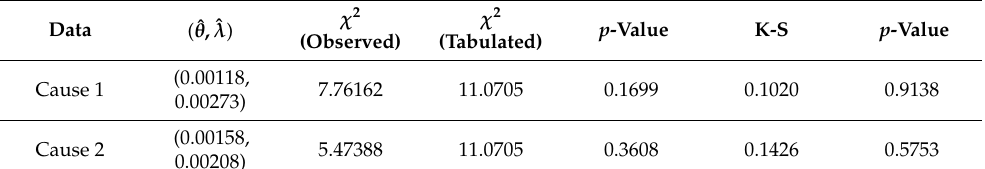
Table 5. The test statistics for Chi-square ( χ 2 ) and Kolmogorov-Smirnov (K-S) from Xia et al. (2009). χ 2 Data ( ˆ θ , ˆ λ ) (Observed)